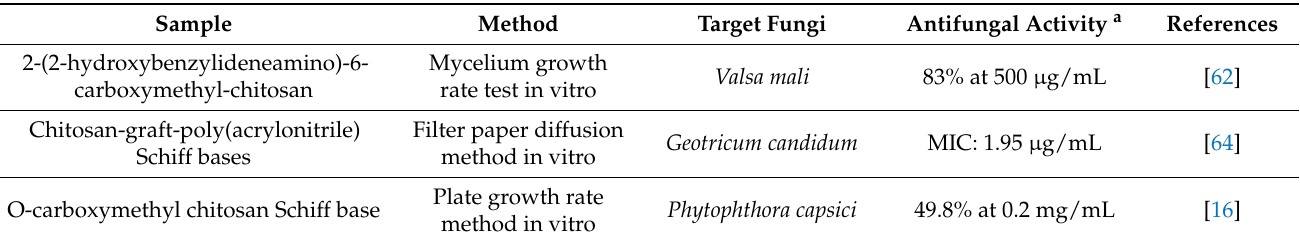
Table 4. Antifungal properties of some chitosan quaternary ammonium salts.